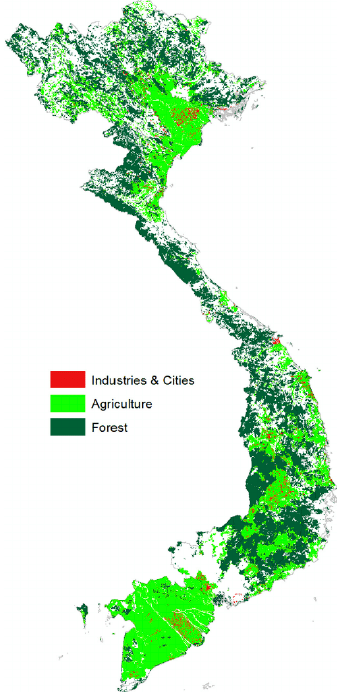
Figure 2. Agricultural regions in Vietnam.